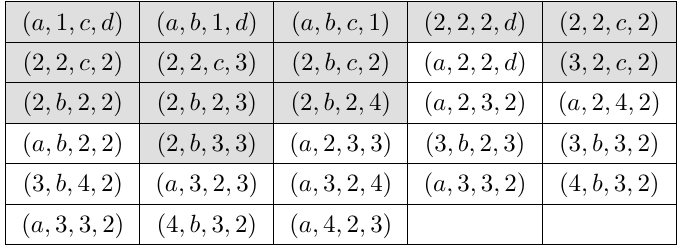
Table 16 . Infinite sequences of type XII singularities. The gray entries are either reducible to previous types or have at least one of b, c, d = 1 , which gives trivial 1-form symmetry. This table is adapted from